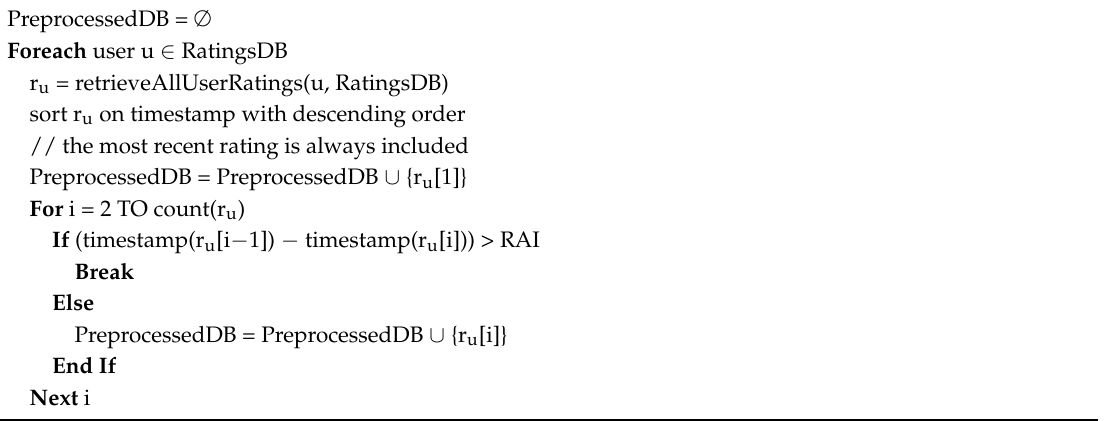
Listing 1 Pseudocode for the rating abstention interval (RAI)-based preprocessing algorithm PreprocessedDB =